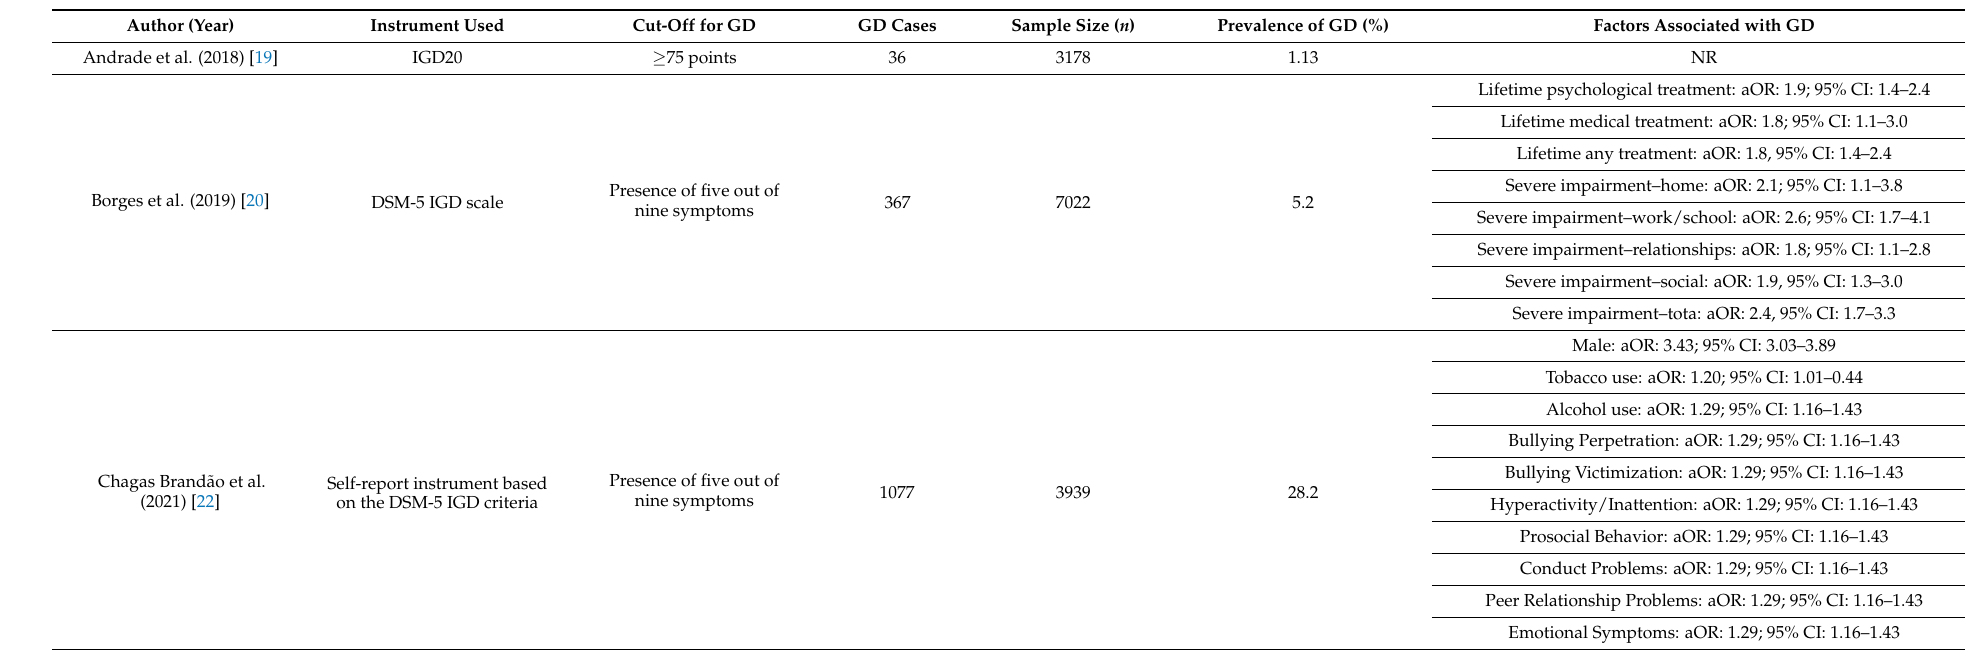
Table 2. Prevalence and factors associated with gaming disorder in Latin America and the